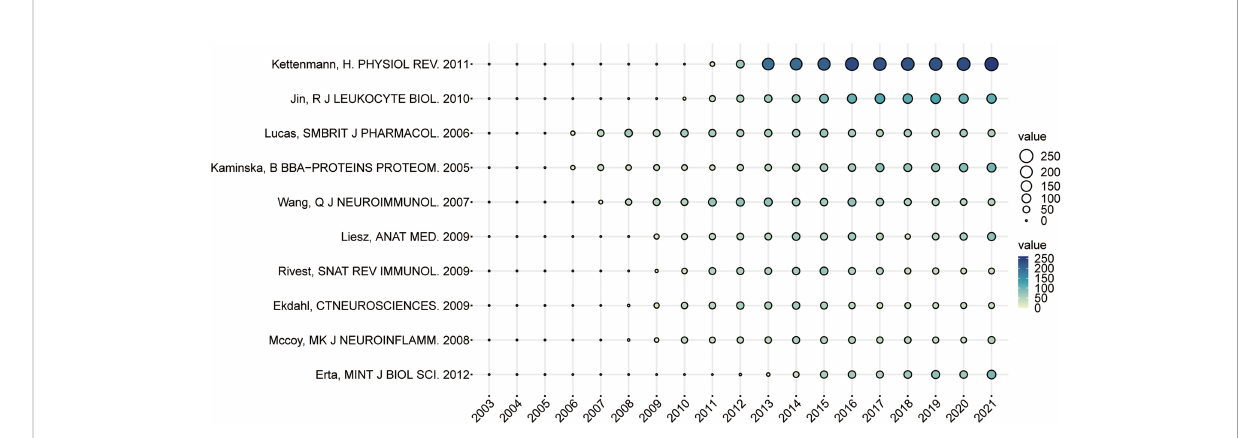
FIGURE 8 Annual global citations for papers with high GCS, where the size and color of the circles represent the GCS of the